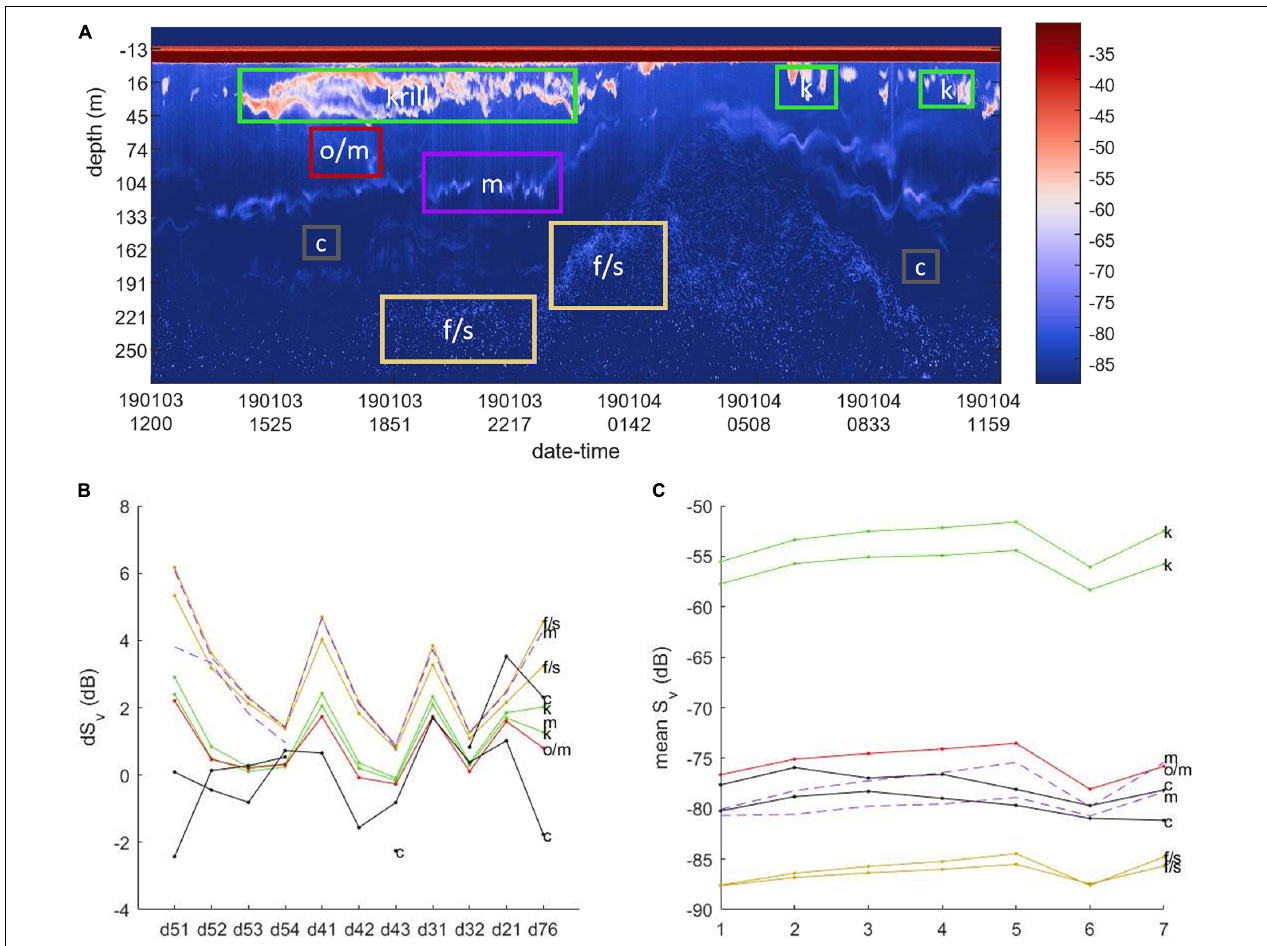
FIGURE 3 | Target classification using S v data, demonstrated using (A) an example echogram with regions marked by class: krill (k), midwater (m), clear water (c), fish or squid (f/s); (B) dSv (dB) by class and frequency-bin pairs, and (C) S v by class and frequency